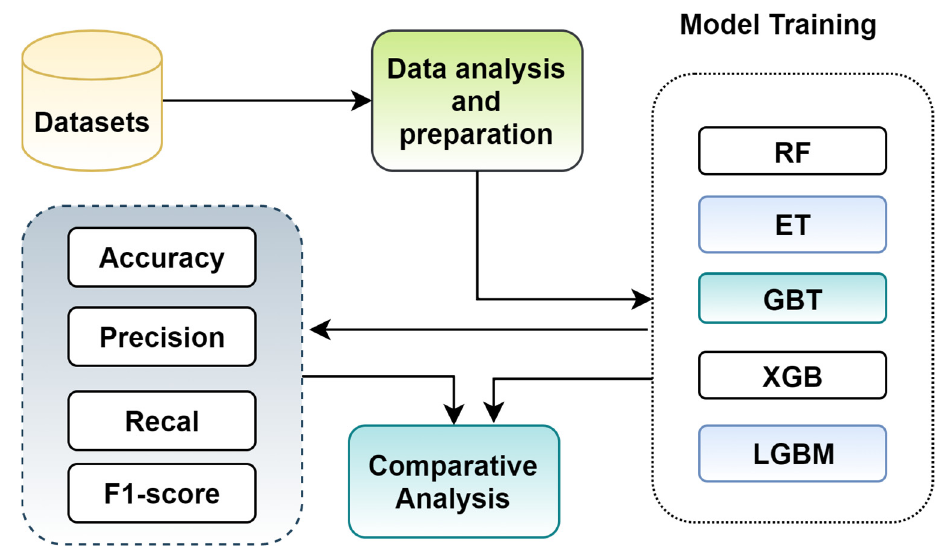
Figure 2. High level methodological steps.